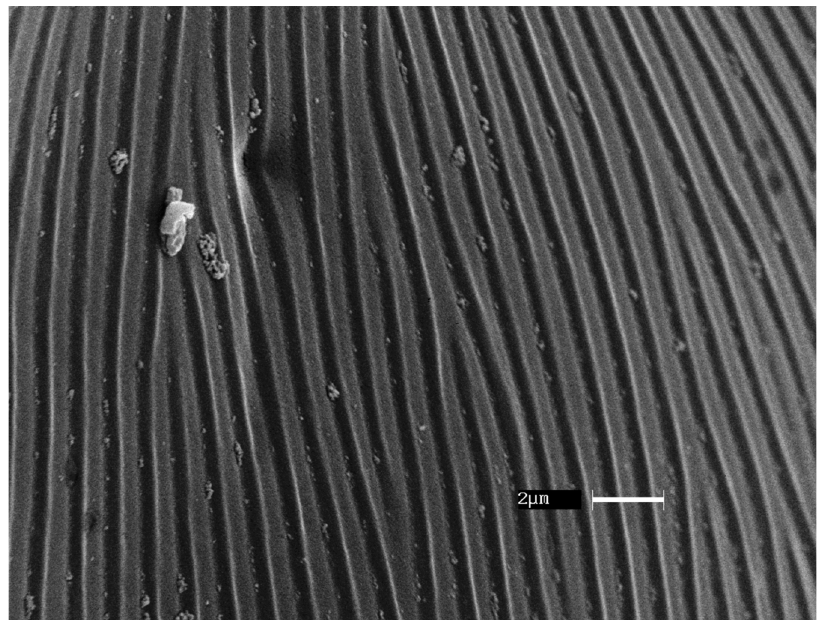
Fig. 12. Detail of inters- cutal membrane in Phy- toseiulus persimilis (Athi-